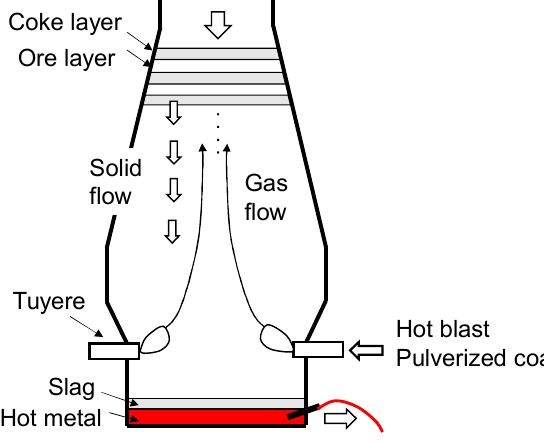
Figure 1. Overview of blast furnace process.